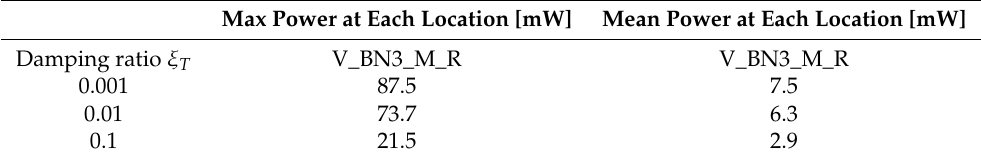
Table 3. The mean power estimates of the vertical and transversal bogie vibrations with a 0.1 kg mass, 45.9 Hz natural frequency, and three di ff erent total damping ratios.